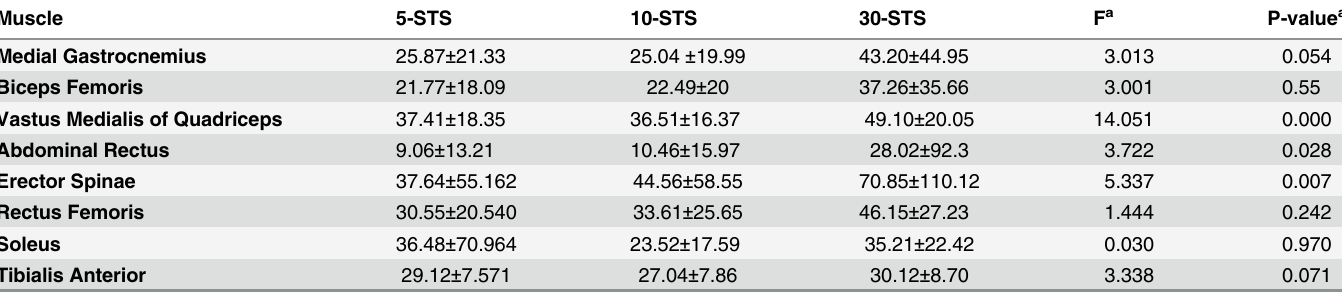
Table 4. Percentage MVC during STS test variants (mean ± SD) in total sample (n = 30) and ANOVA (f,p) test. Muscle 5-STS 10-STS 30-STS F a P-value a